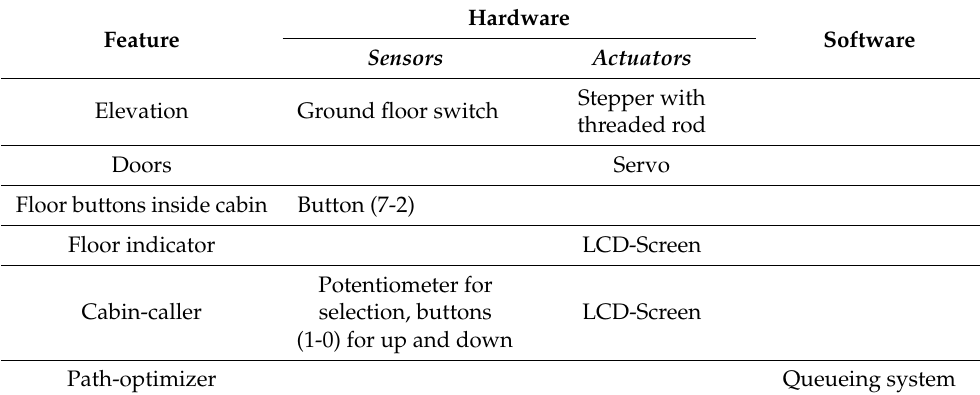
Table 3. Mapping table for the elevator model.